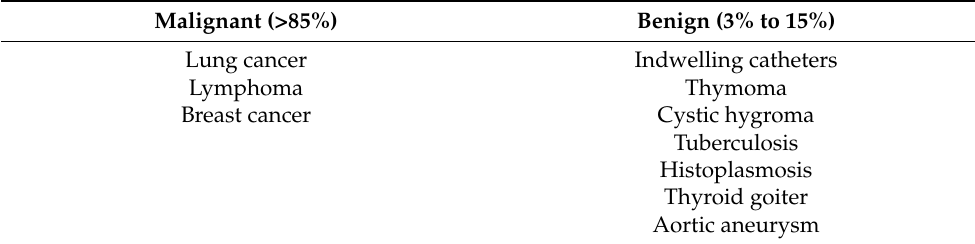
Table 1. Common causes of superior vena cava